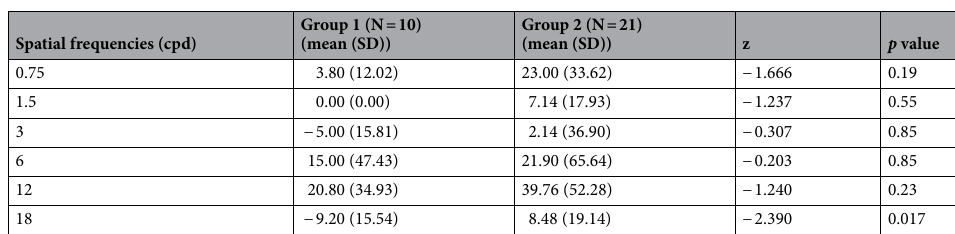
Table 4. Mean differences between contrast sensitivity conditions for all spatial frequencies. A positive value corresponds to worsened contrast sensitivity after smoking cannabis. Mann–Whitney U test was applied for